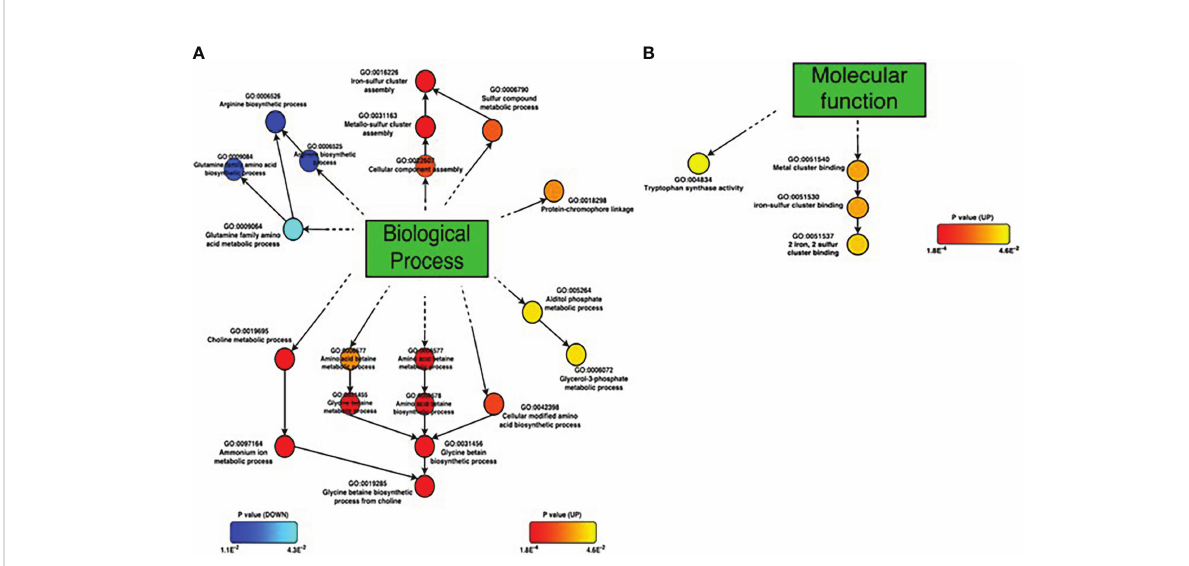
FIGURE 5 GO term enrichment analyses ofSet2B.DEGs. (A) Biological process, (B) Molecular function. Circles represent each GO term; up-regulated GO terms are shown by red to yellow, and down-regulated GO terms are shown by blue to cyan. GO terms closed to red and blue colors are signi fi cantly regulated based on p